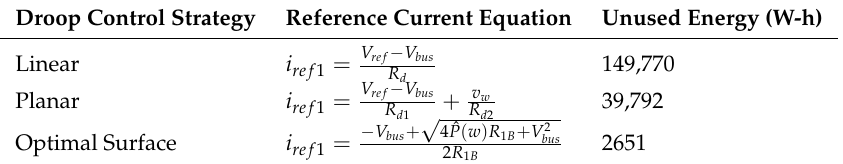
Table 4. Comparison of unused energy from the wind for three droop control methods, in a full microgrid